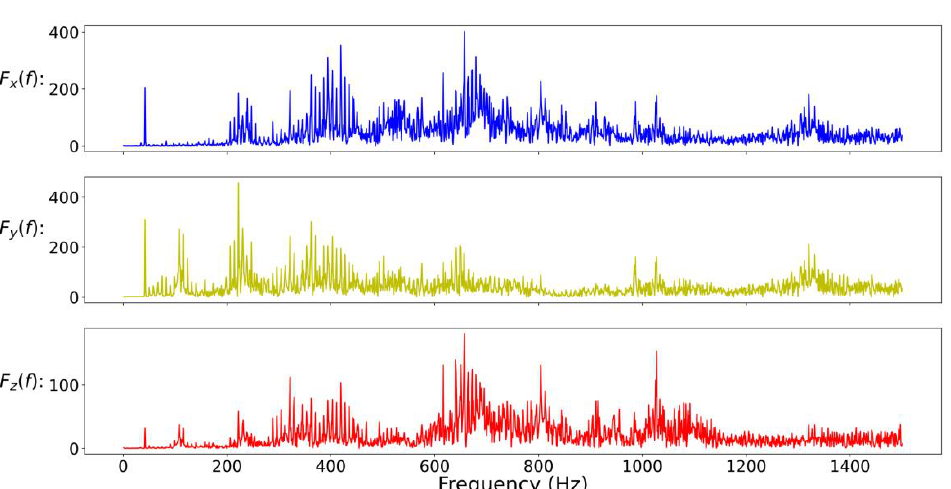
Figure 8. Full-time (FT) data.